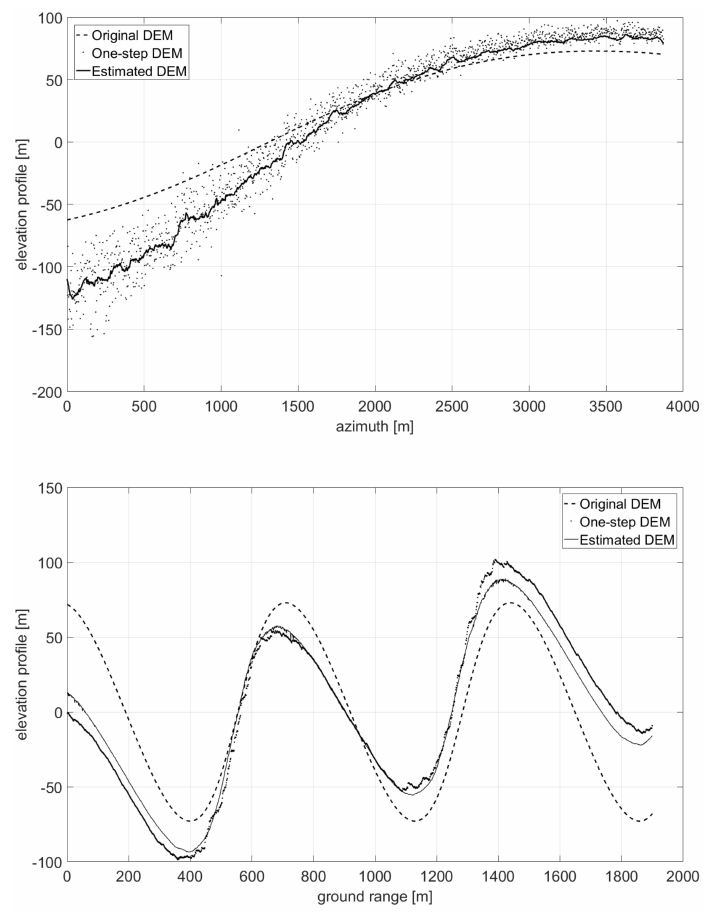
Figure 9. Comparison of original and estimated ( a ) range and ( b ) azimuth profiles in presence of speckle before and after the azimuth regularization filtering assuming unknown starting